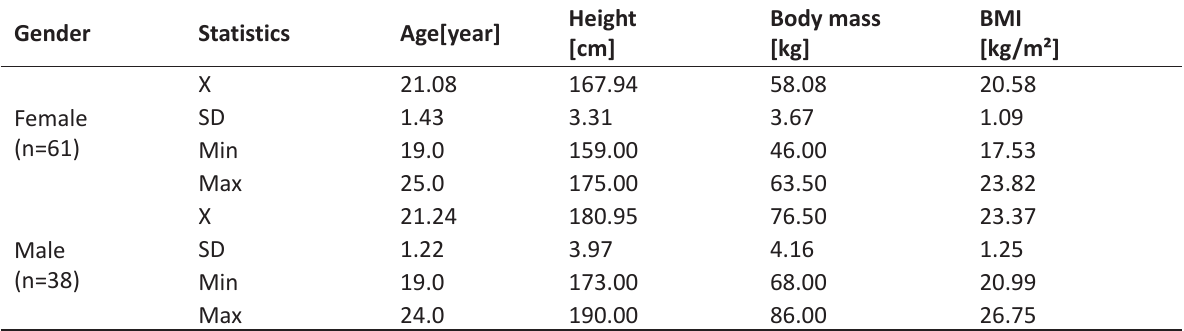
Table 1. Anthropometric characteristics of participants at the beginning of the study